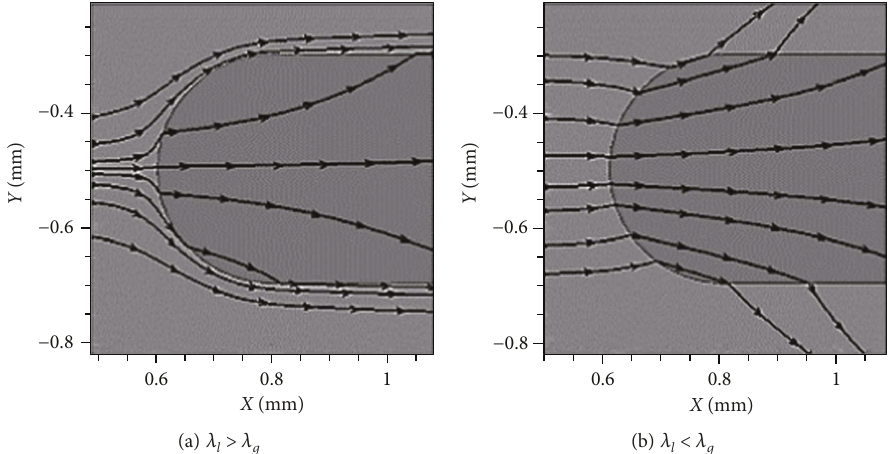
Figure 3: Vector diagram of heat fl ow through a phase interface (the light-colored area is the liquid phase, and the dark area is the gas